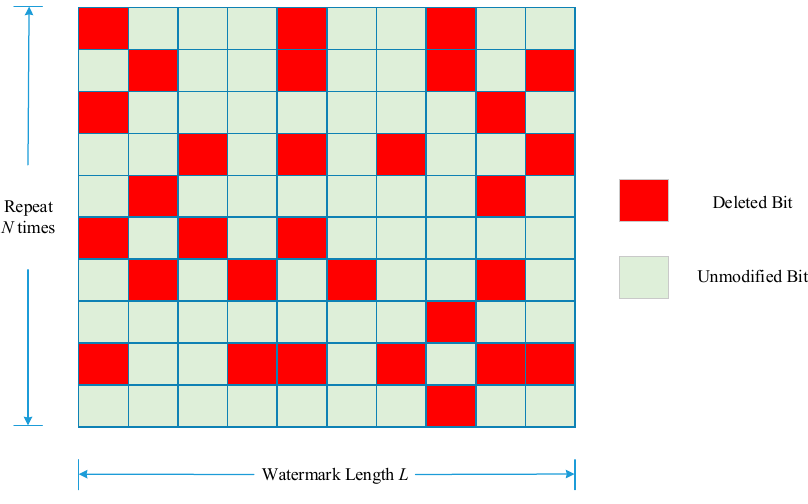
Figure 7. An example belongs to enumerations of function P .